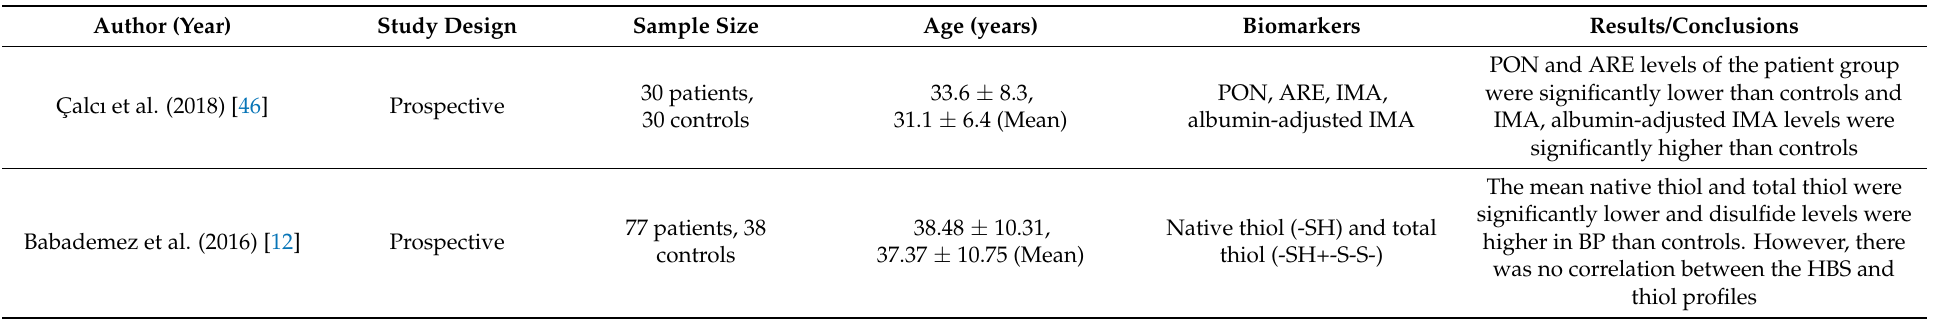
Table 5. Summary of prognostic biomarkers for acute peripheral facial palsy (Oxidative